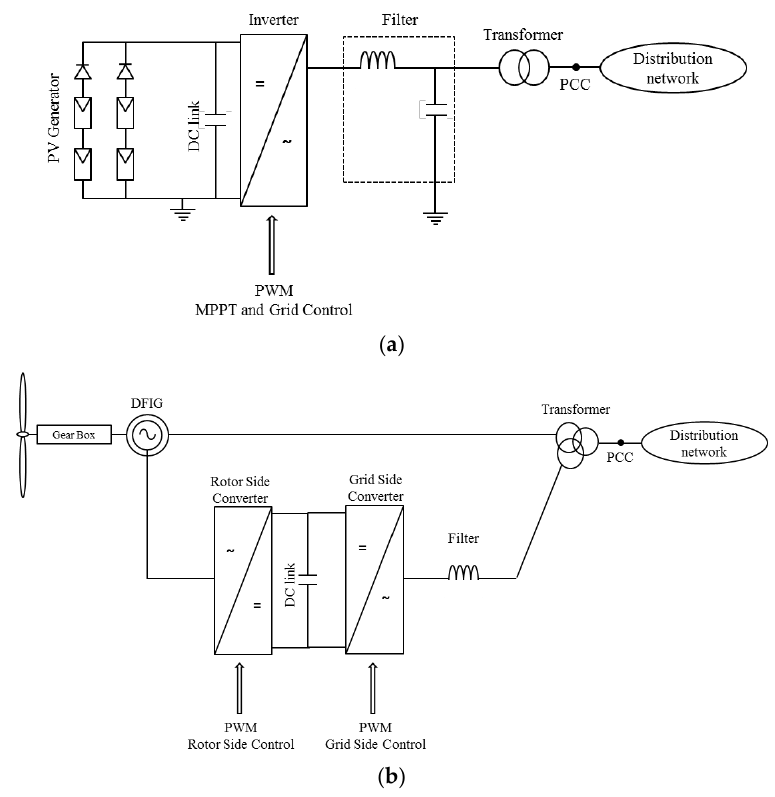
Figure 1. Block scheme of: ( a ) a photovoltaic system (PVS) and ( b ) a wind turbine system (WTS).